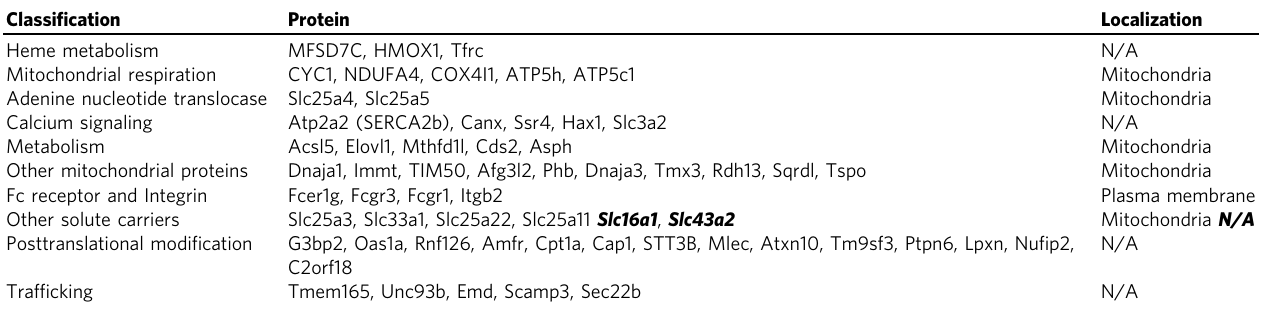
Table 1 List of proteins co-immunoprecipitated with